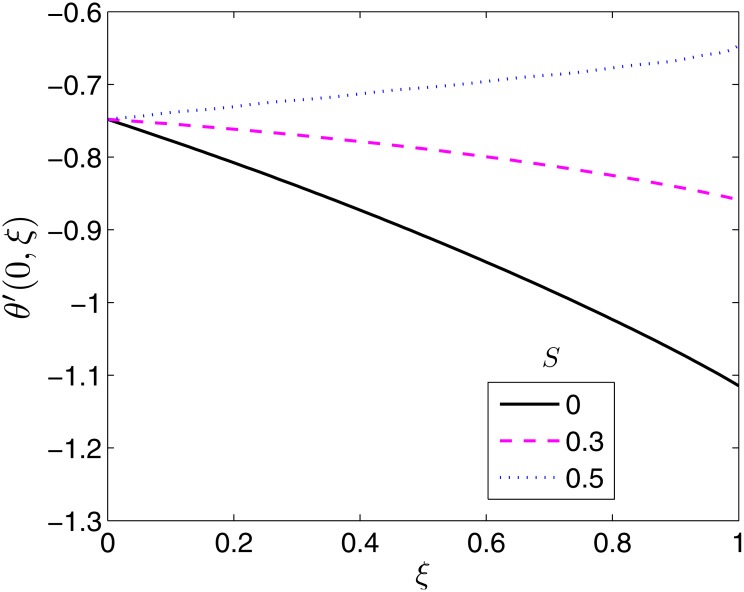
Effect of S on θ′(0, ξ).
β = 0.5, β
1 = 0.5, β
2 = 1ϵ = 0.1, Pr = 2.